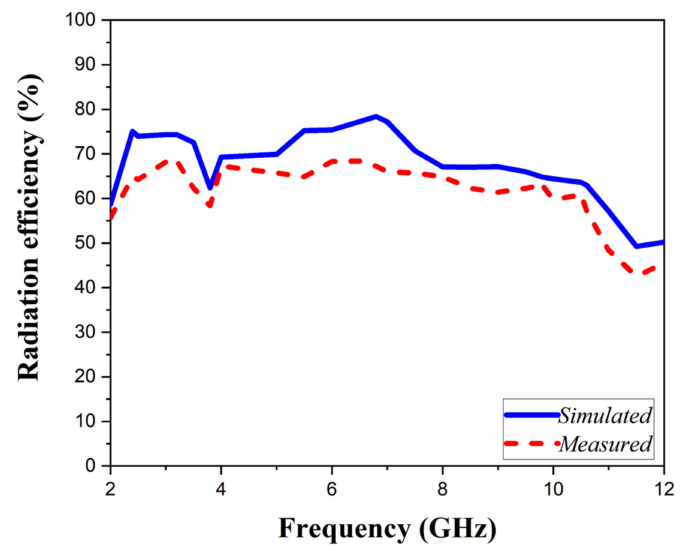
Figure 16. Simulated and measured radiation efficiency for the designed Sierpinski hexagonal-shaped fractal antenna.